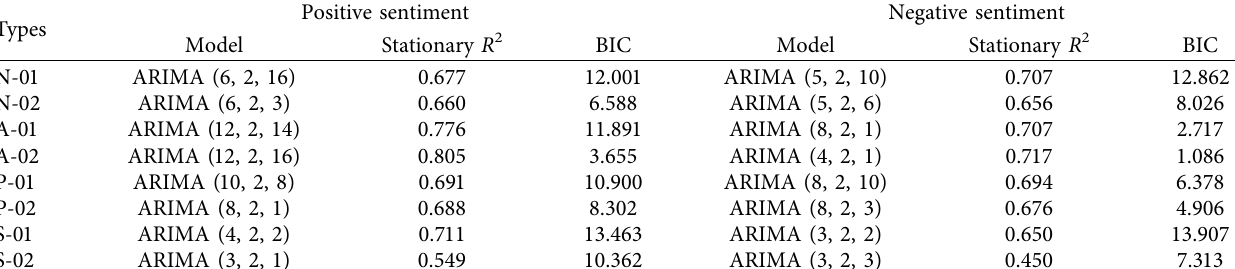
Table 6: ARIMA model test results of the sentiment data